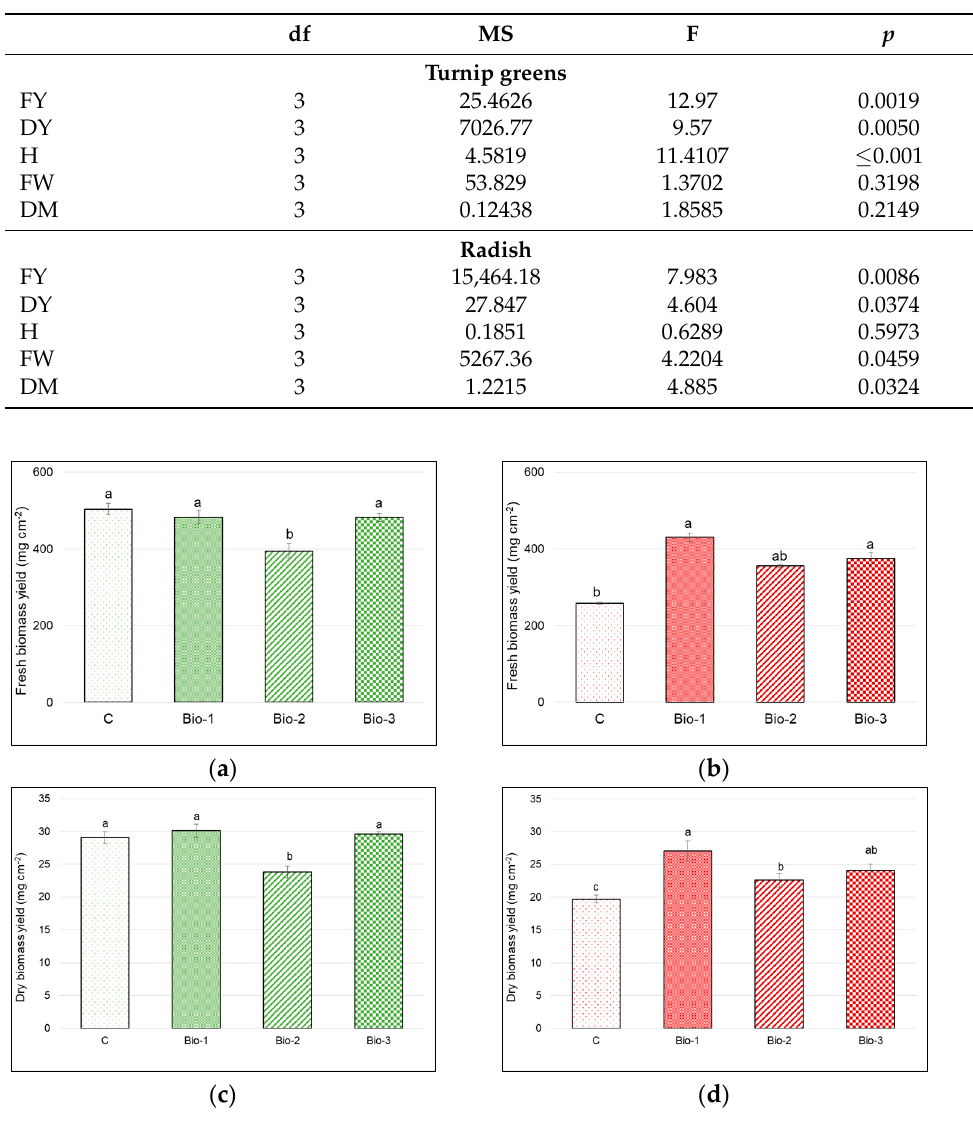
Figure 1. Effect of biostimulants (Bio-1 = TRAINER ® ; Bio-2 = AQUAMIN, and Bio-3 = Moringa oleifera leaf extract) on fresh and dry biomass yield (mg cm − 2 ) in turnip greens ( a , c ) and radish ( b , d ) of microgreens. Data are means ± se ( n = 3). Different letters indicate significance at p ≤ 0.05 according to the LSD test. Table 1. Results of one-way ANOVA for fresh (FY) and dry biomass yield (DY), seedling height (H), seedling fresh weight (FW) and seedling dry matter percentage (DM), in microgreens of turnip greens and radish.